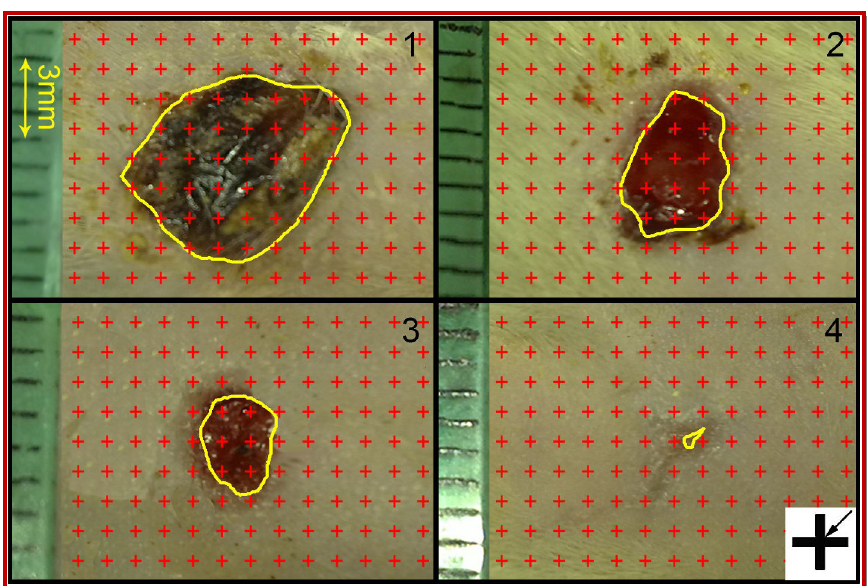
Figure 1: Samples of digital photographs were captured from the wound surfaces every other day to measure the wound area. The total number of points within the wound borders (yellow line) was counted. At the corner of this figure, a cross is presented. The right upper corner of the cross is considered as the point (arrow), and it is counted only if the right upper corner hits the wound surface. (1): day 1, (2): day 4; (3) day 8; (4) day 12